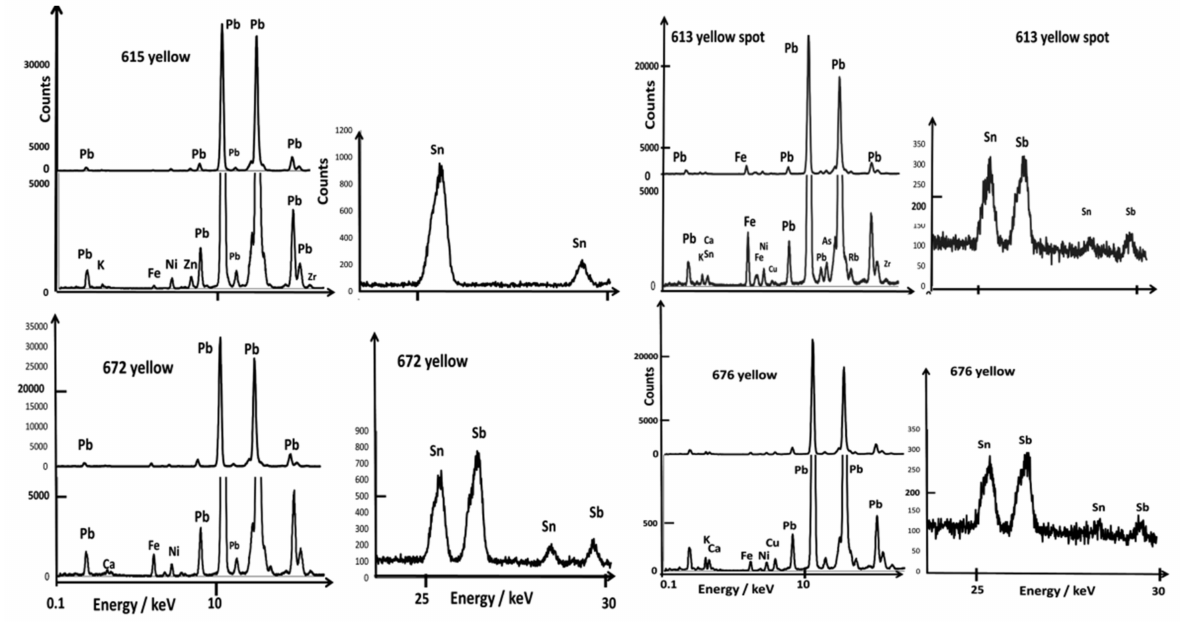
Figure 6. Comparison of representative XRF spectra for yellow painted decor in the 0.1–20 and 20–30 keV energy